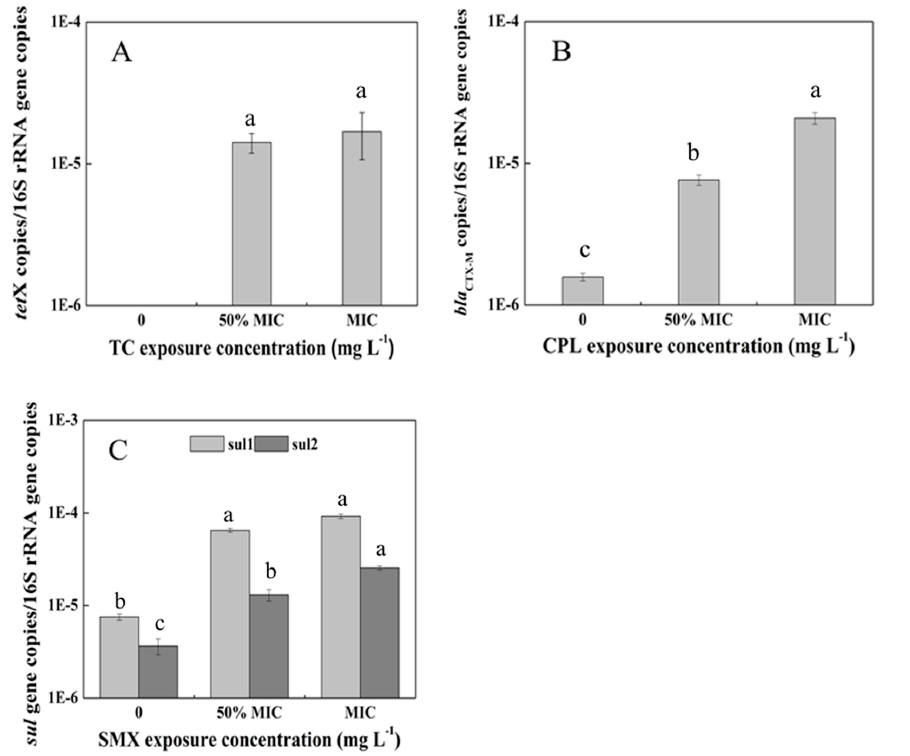
Figure 4. Abundance of antibiotic resistance genes (ARGs) in the endophytic system of pakchoi under different dosages of antibiotic exposure . ( A ) tet X gene in TC ‐ treated plants; ( B ) bla CTX ‐ M gene in CPL ‐ treated plants; ( C ) sul 1 and sul 2 genes in SMX ‐ treated plants. Values are mean ± SD ( n = 3). Different letters on the top of the error bars indicate statistical difference among the treatments ( p < 0.05).